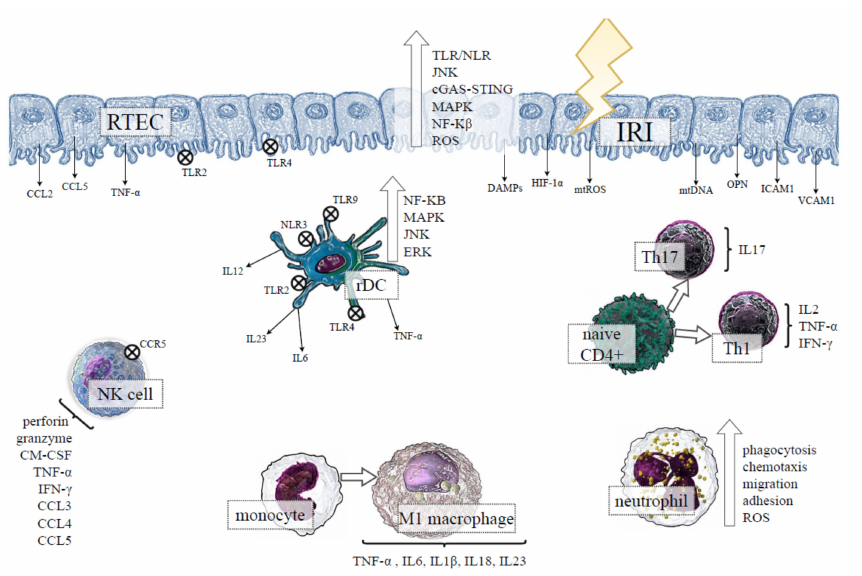
Figure 1. The effect of ischemia-reperfusion injury (IRI) on the renal tubular epithelial cells (RTECs) and the activation of innate immunity in kidney tissue. Under ischemic conditions, RTECs undergo injury and death, releasing diverse DAMPs, the products of oxidative stress, proinflammatory cytokines and chemokines, which can activate TLRs/NLRs, and distinct intracellular proinflammatory pathways in the neighbouring kidney cells along with the cells of the innate immune system. The results indicate the activation of rDCs, which intercommunicate with other cells of the immune system through proinflammatory cytokines secretion. After reperfusion, the recruitment of